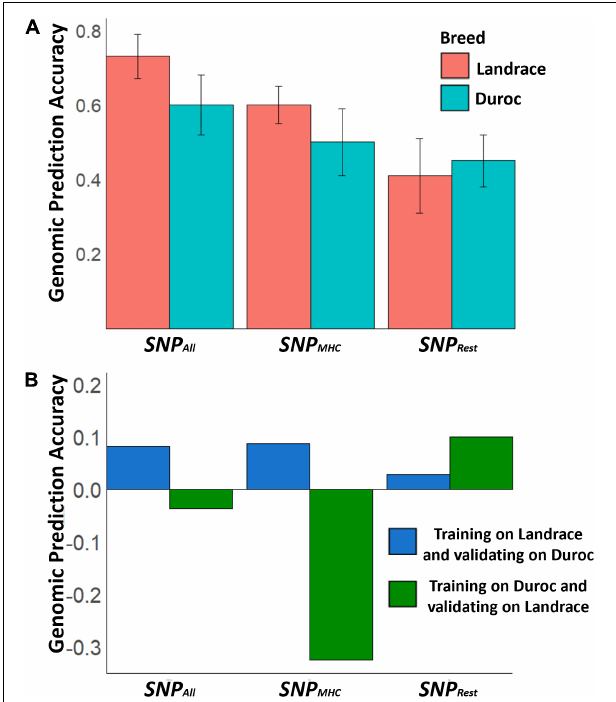
FIGURE 3 | Genomic prediction accuracies of sample-to-positive (S/P) ratio across different SNP sets. (A,B) Genomic prediction accuracies for the within-breed and between-breed genomic prediction, respectively. SNP All represents the set of SNPs using all 29,799 SNPs across the genome, while SNP MHC accounts for only SNPs in the QTL that harbors the major histocompatibility complex (MHC) region. For SNP Rest , all SNPs across the genome were used excluding those in the MHC region and a 2-Mb window surrounding the QTL in the MHC region to avoid having any SNPs in linkage disequilibrium with this QTL. The error bars in panel (A) represent the standard deviations across the 5-fold used to calculate genomic prediction